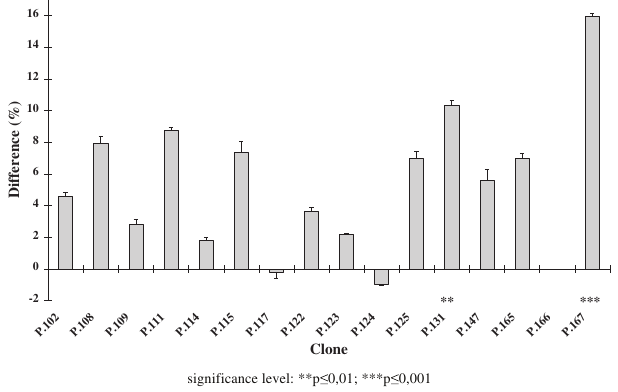
Figure 4. The divergences in sugar content of the must of selected ‘Kadarka’ clones from the P. 9 clone (Szekszárd - Batti field, 2010)